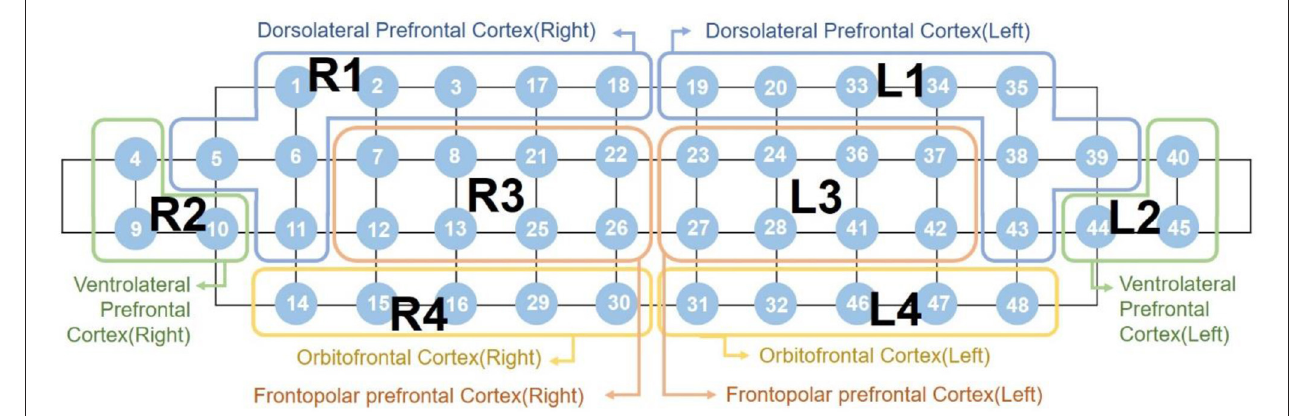
FIGURE 1 | Labeling of the eight subregions mapped by 48 channels “R” indicates the right hemisphere, while “L” indicates the left